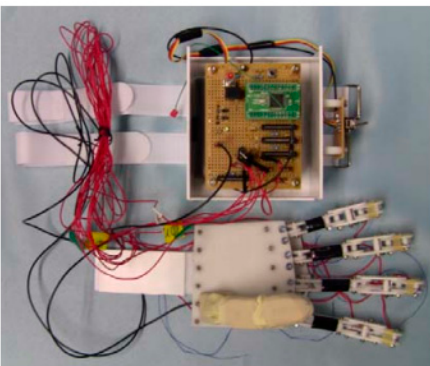
Figure 7. The prosthetic hand and the controller which is embedded into the palm [27].